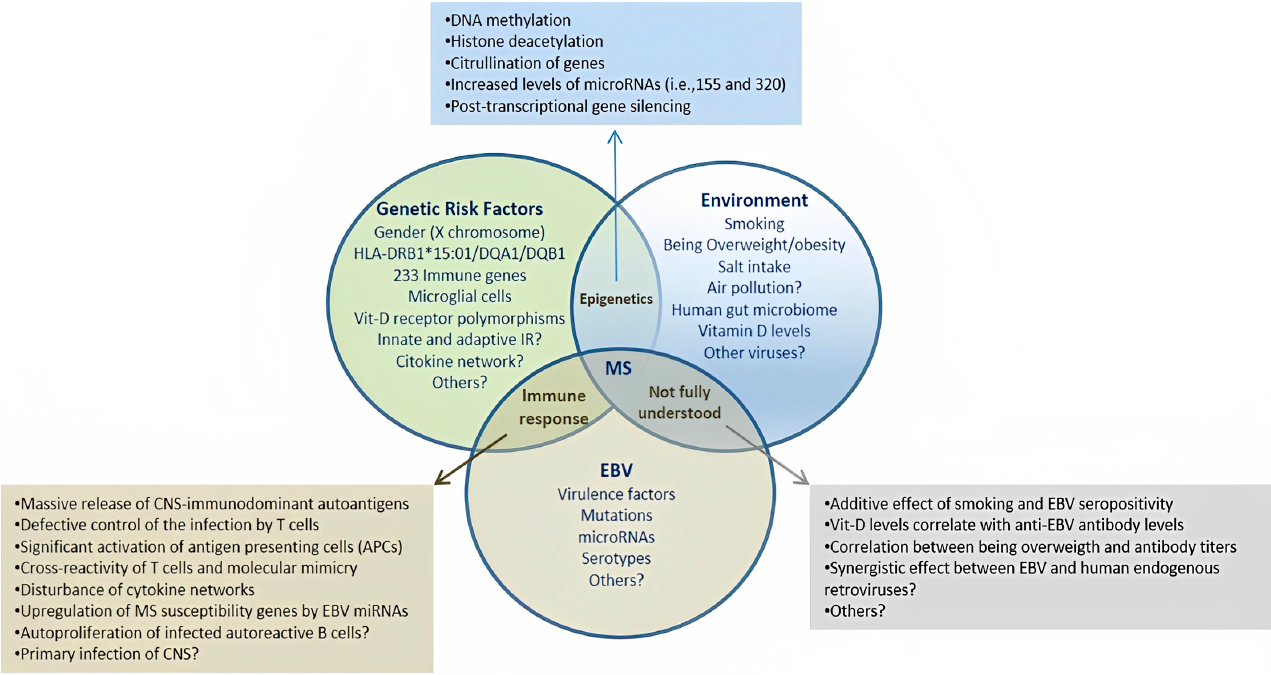
Figure 1. Interaction among different risk factors for multiple sclerosis (MS). A number of genetic, epigenetic and environmental factors have been associated with MS. However, EBV infection is now considered an essential condition for disease onset. Recent evidence also suggests that EBV may duplicate the risk of MS when other risk factors coexist in the same individual. Although there is a lack of agreement regarding some of the factors listed in the diagram, these interactions can be further studied through various methods using biological specimens taken from susceptible individuals. This may also provide a unique opportunity to disentangle the origins of this complex and enigmatic disease. IR: immune response.